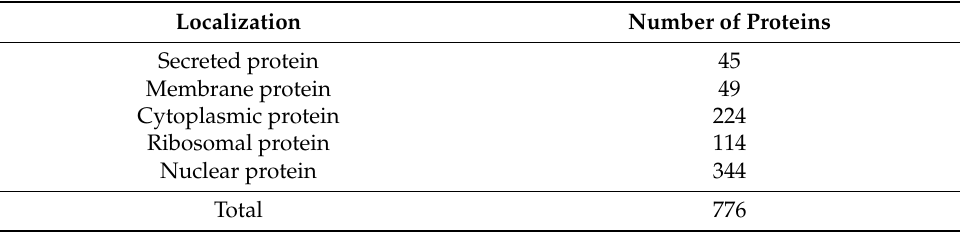
Table 2. Subcellular localization of Histoplasma capsulatum proteins by PSORT.